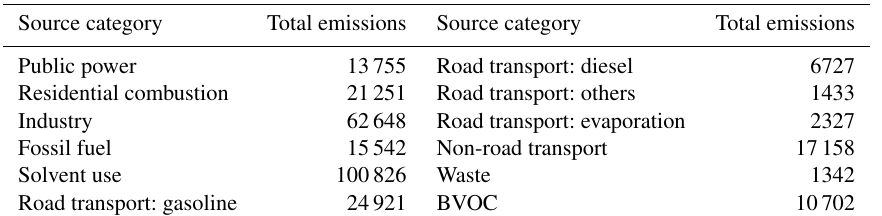
Table 1. Total AVOC emissions in 2011 in tonnes from each anthropogenic source category assigned from TNO-MACC_III emission inventory and temperature-independent BVOC emissions from the Benelux region assigned from EMEP. The allocation of these emissions